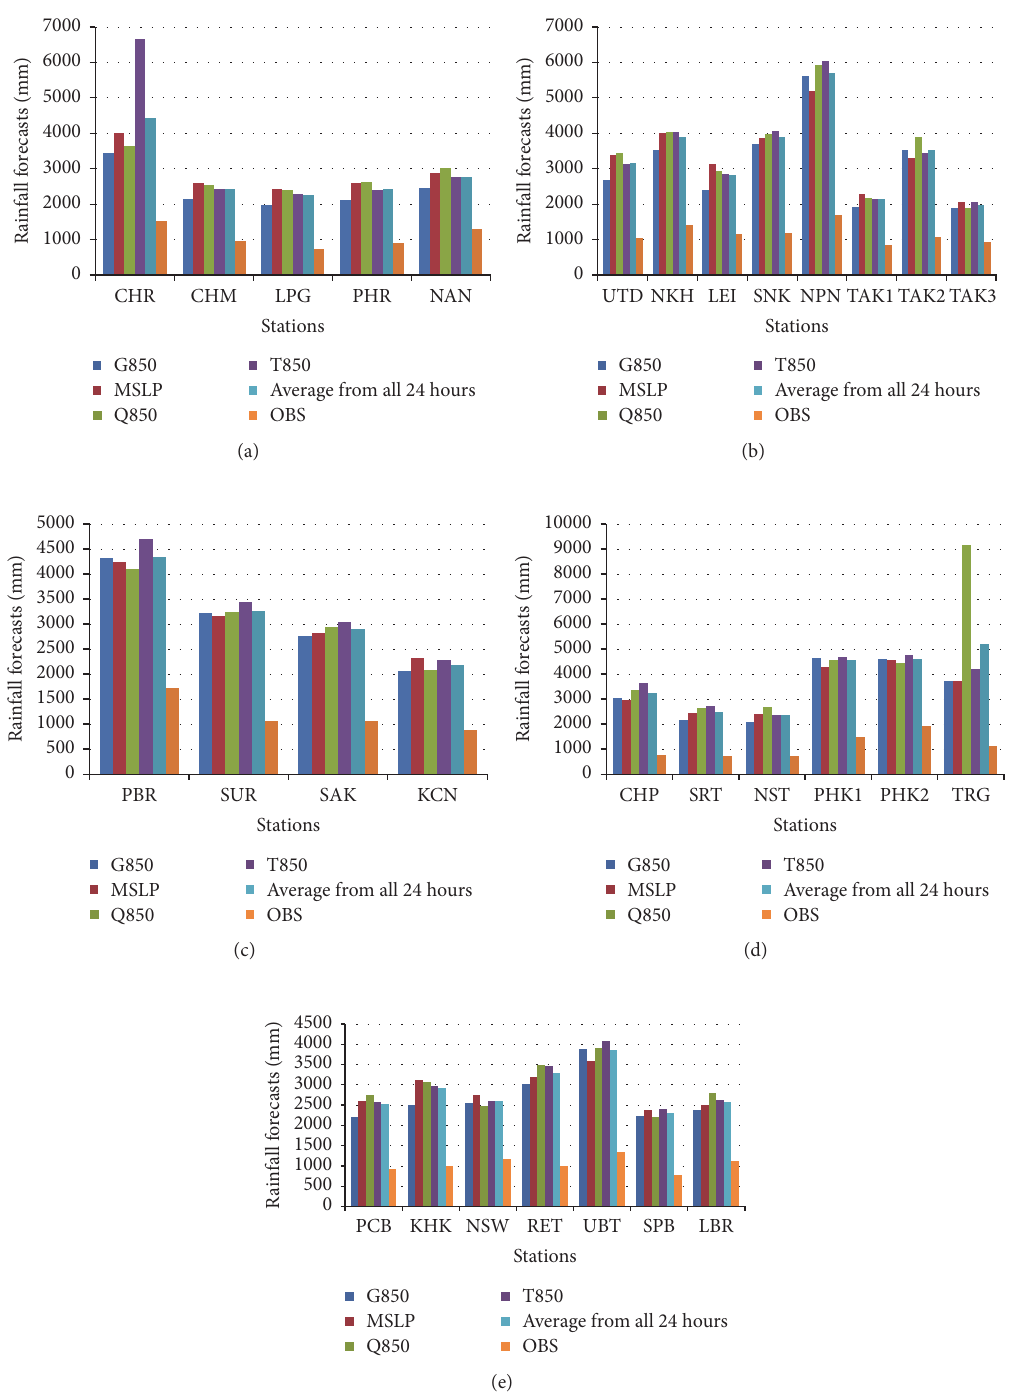
Figure 11: The histogram of the comparison between observed stations and simulations for four predictors, represented by an average from all 24 hours, mean sea level pressure, temperature, moisture, and geopotential height at 850 hPa of CAM decomposition. This study shows five provinces: (a) northern, (b) northeast, (c) western, (d) southern, and (e)